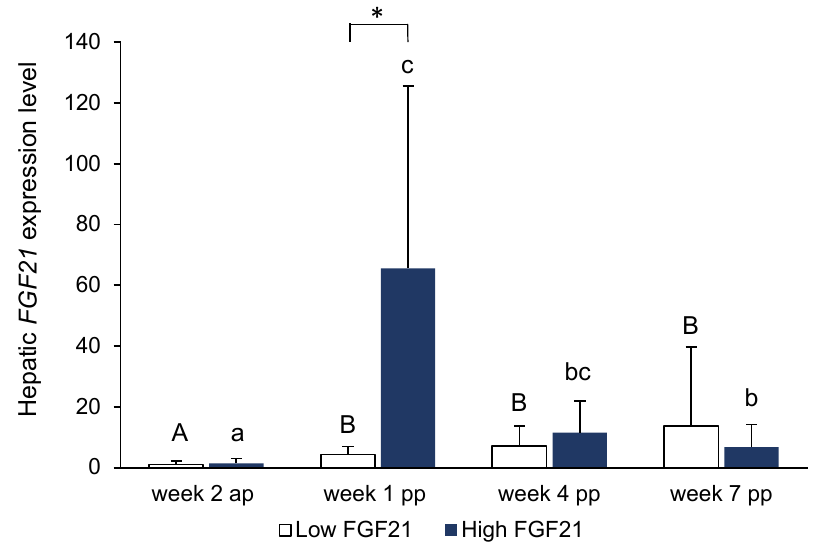
Figure 1. Hepatic FGF21 expression levels in groups of cows with low versus high hepatic FGF21 expression at week 2 antepartum, week 1 postpartum, week 4 postpartum, and week 7 postpartum, as analyzed by qPCR ( n = 8/group). * An asterisk indicates a significant difference between groups. Means without the same uppercase letters (A, B) are significantly different within the low FGF21 group; means without the same lower case letters (a, b, c) are significantly different within the high FGF21